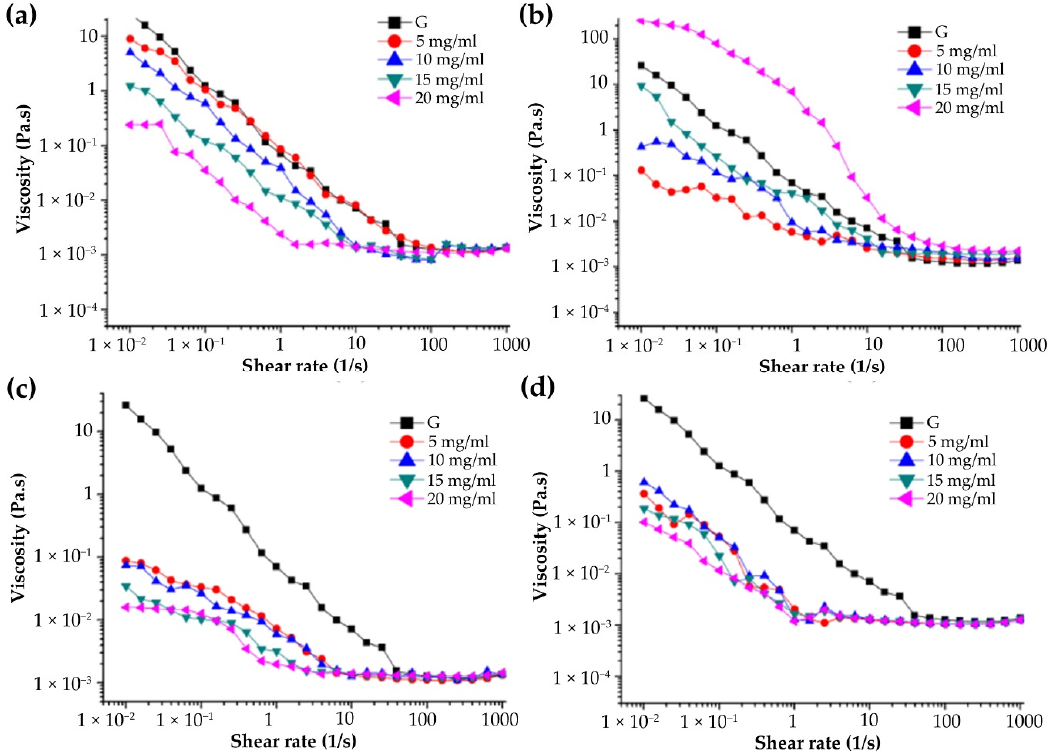
Figure 5. Effect of different concentrations on the viscosity of G ‐ MLPs. ( a ) G ‐ HBSS; ( b ) G ‐ CHSS; ( c ) G ‐ DASS; ( d ) G ‐ CASS.